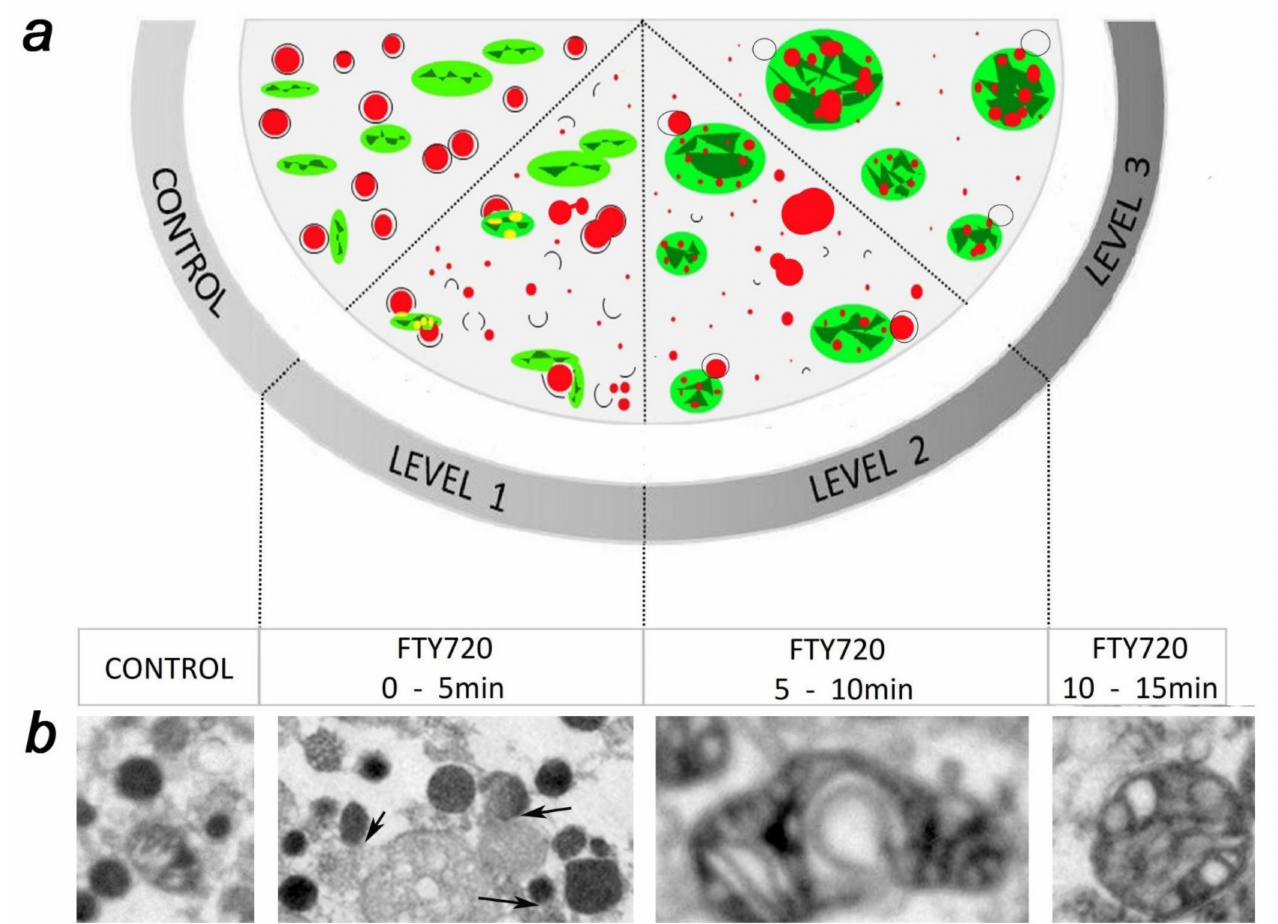
Figure 2. FTY-720 induces drastic changes in vesicles and mitochondria in chromaffin cells. ( a ) Schematic of the changes induced by 20 µ mol/L FTY-720 incubation of cultured bovine chromaffin cells after a variety of incubation times, where the dense vesicles are depicted in red and mitochondria in green. ( b ) Micrographs showing examples of the changes by using electron microscopy. Three levels of changes are proposed: (1) Rapid formation of microvesicles from dense organelles (dark round organelles) and initiation of the fusion with mitochondria as indicated by arrows, (2) Heterotypic fusion of vesicles with mitochondria to form elongated mixed organelles, and (3) Formation of round mixed macroorganelles consisting of mitochondria incorporating the dense cores of several